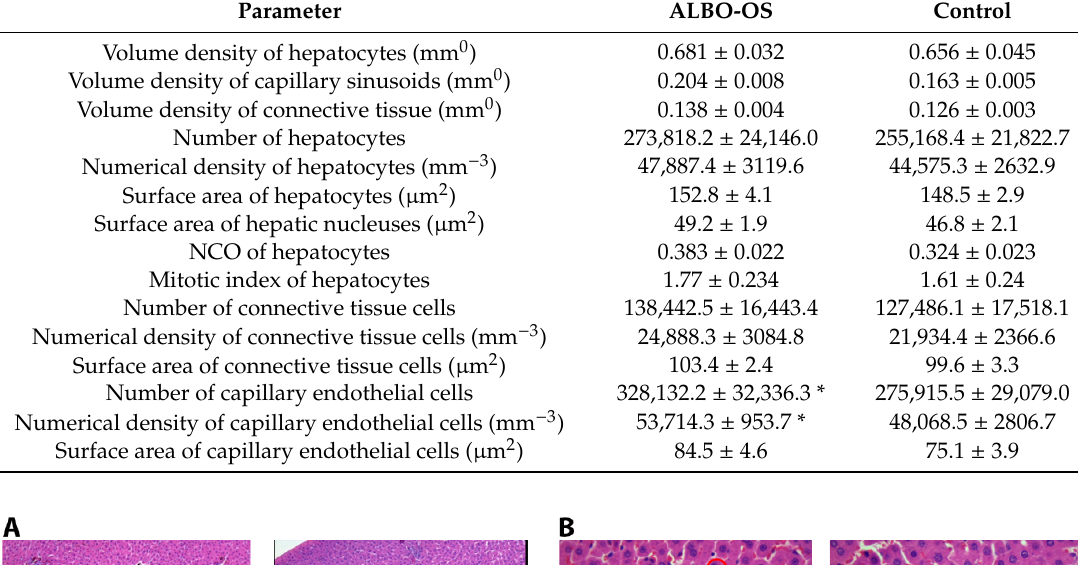
Table 3. Stereological parameters of the liver of the control and treated groups of rats; values are shown as mean ± SD (* p < 0.05; t -test).